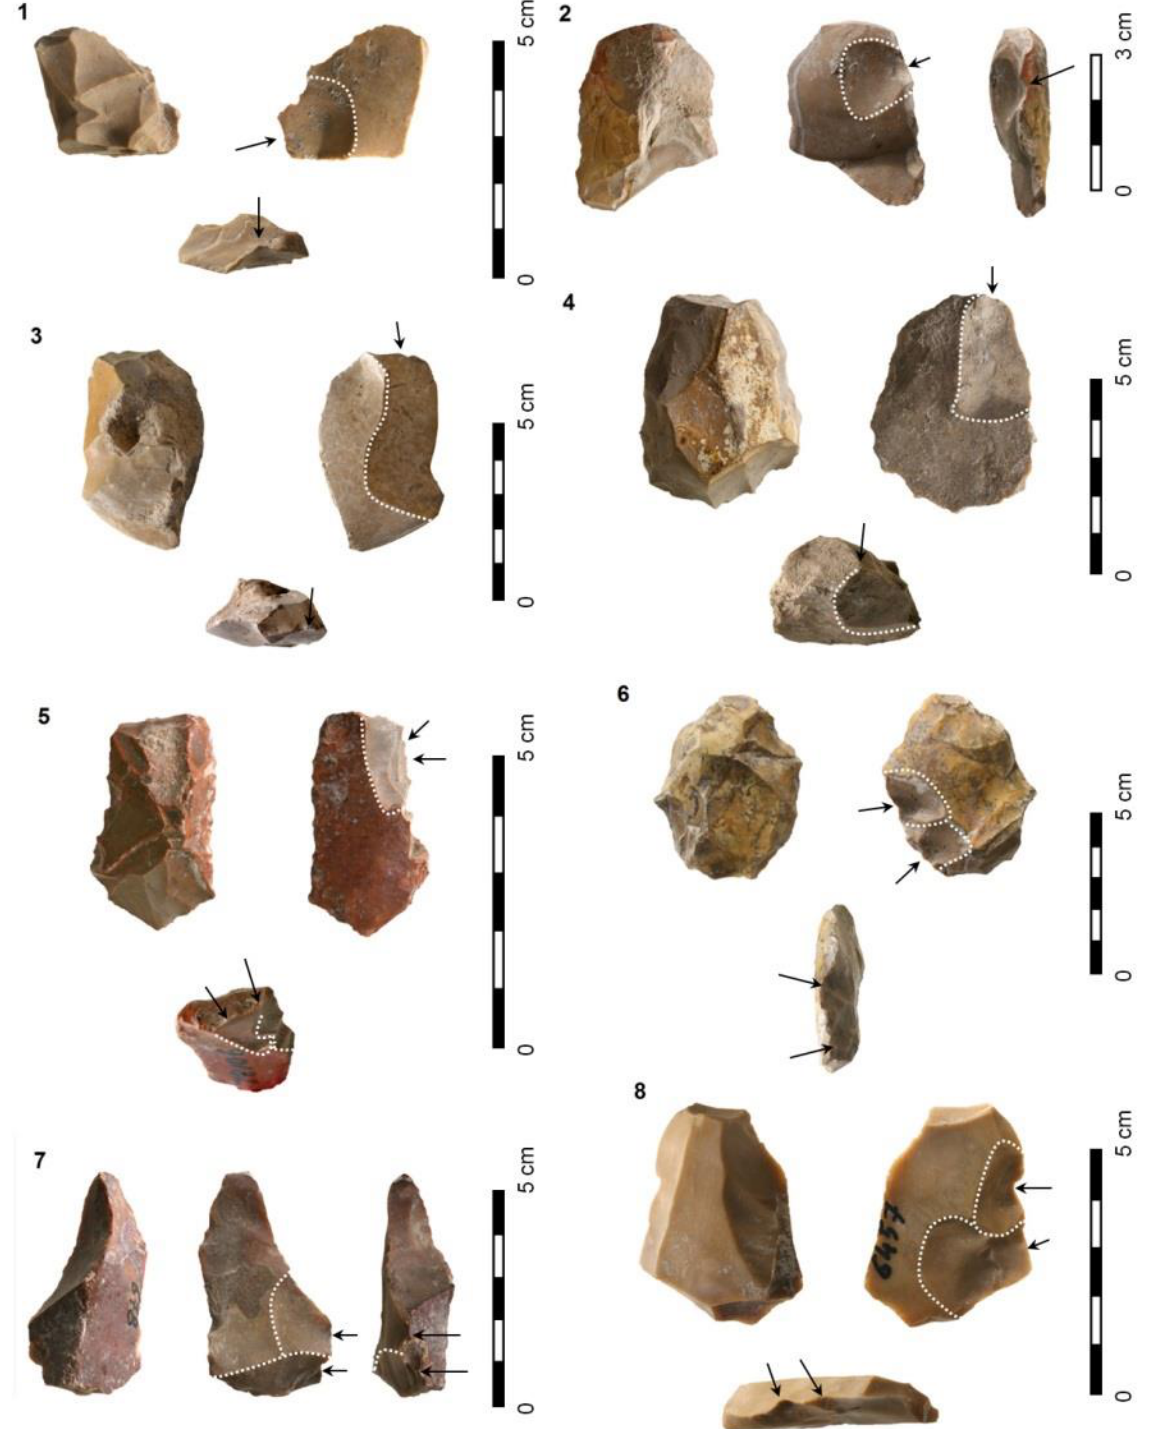
Figure 7. COFs: 1-4 are COFs with single removal; 5 & 6 are COFs with multiple removals on patinated flakes; 7 & 8 are COFs with multiple removals. Dotted white lines denote the scars contour; black arrows denote the direction of